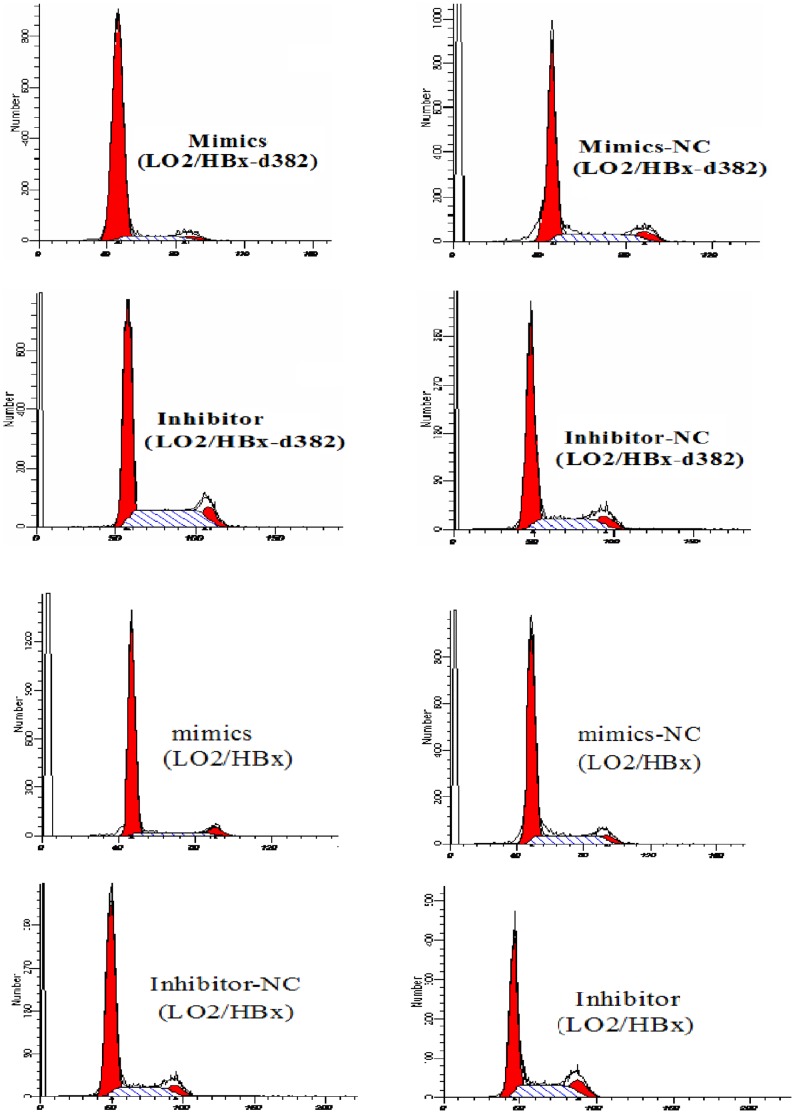
miR-338-3p inhibits cell proliferation, especially in LO2/HBx-d382 cells.(A) A representative cell cycle profile for miR-338-3p mimics or inhibitor in LO2/HBx-d382 and LO2/HBx cells comparing to their control RNA transfection. (B) Average of G1 phase populations in HBx-expressed LO2 cells after transfected miR-338-3p mimics or inhibitor (*P<0.001). (C) Average of S phase populations after transfected miR-338-3p mimics or inhibitor in LO2/HBx-d382 and LO2/HBx cells (*P<0.001). While miR-338-3p overexpresses or suppresses, miR-338-3p induce cell cycle arrest and anti-miR-338-3p increases cell growth, especially in LO2/HBx-d382 cells. Values in (B) and (C) are means ±SD of three separate experiments.